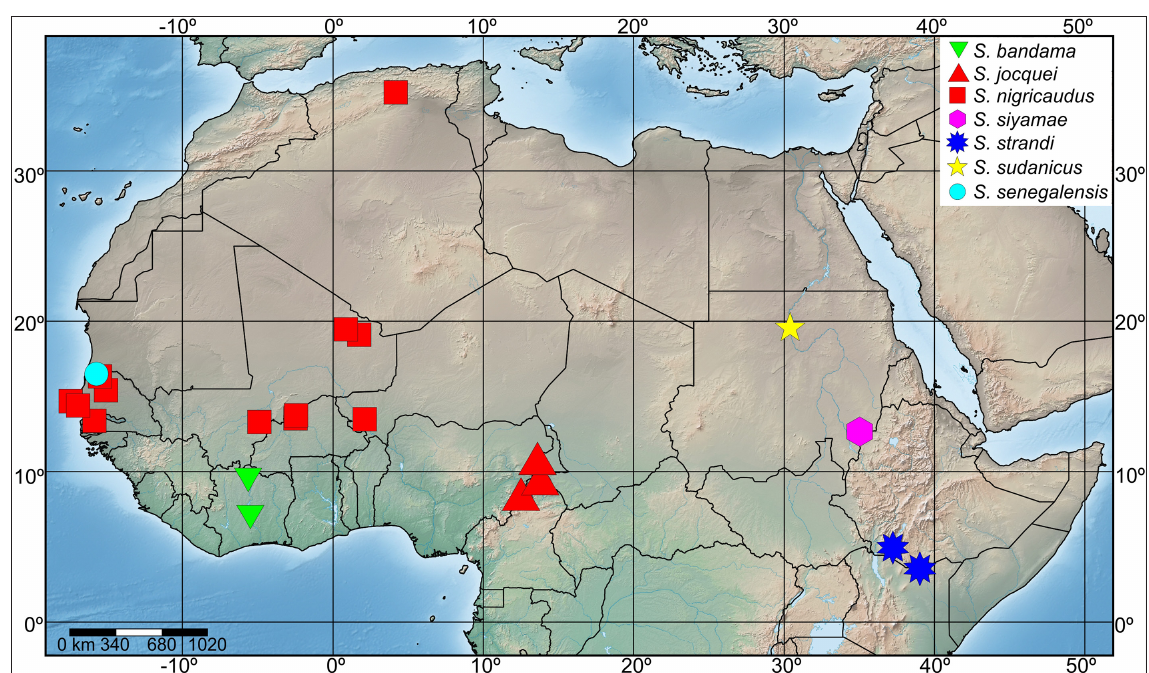
Fig. 510. Collecting localities of seven African species of Stenaelurillus